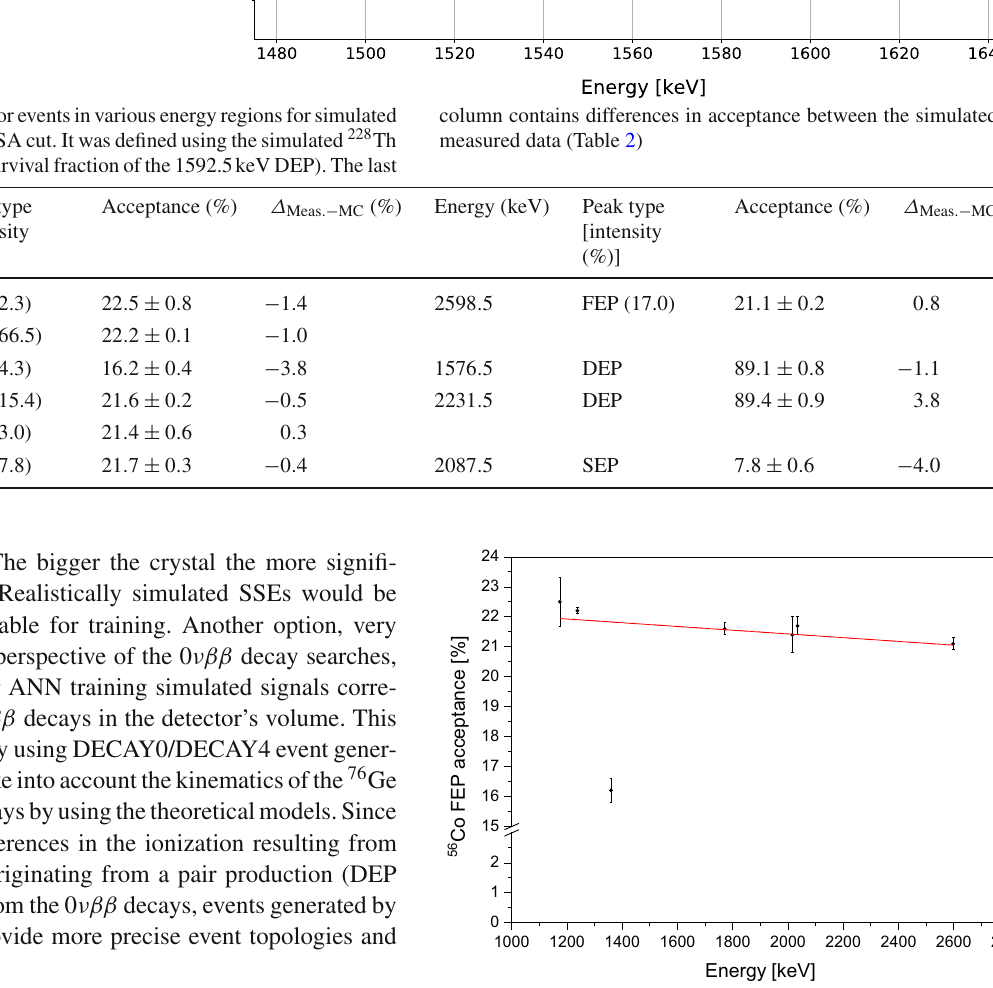
Fig. 18 Close-up of the 228 Th (pulses simulated at 50 K) spectrum before and after the cut rejecting MSEs (the same spectrum as in the bottom panel of Fig. 17), showing the effect of the PSA method on peaks consisting of events of different types. Suppression of MSEs in SEPs and FEPs is clearly visible, while SSEs in the DEPs are mostly accepted